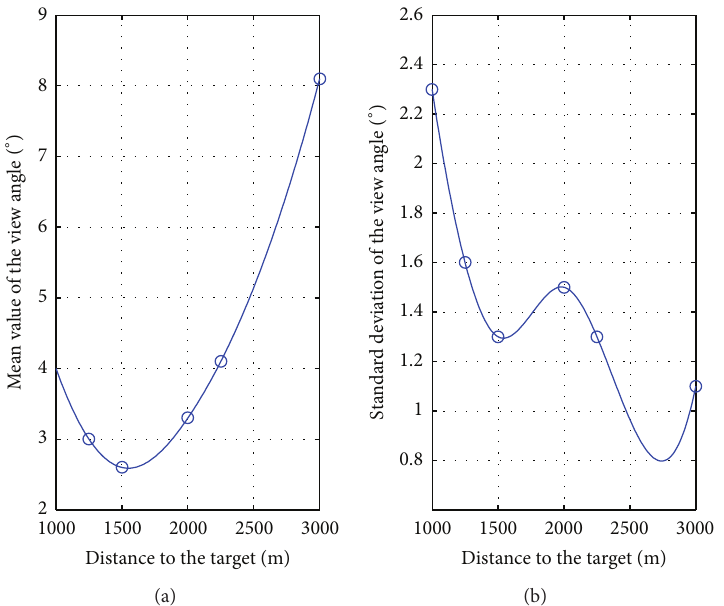
Figure 15: Cubic spline interpolation curve results (fixed target).